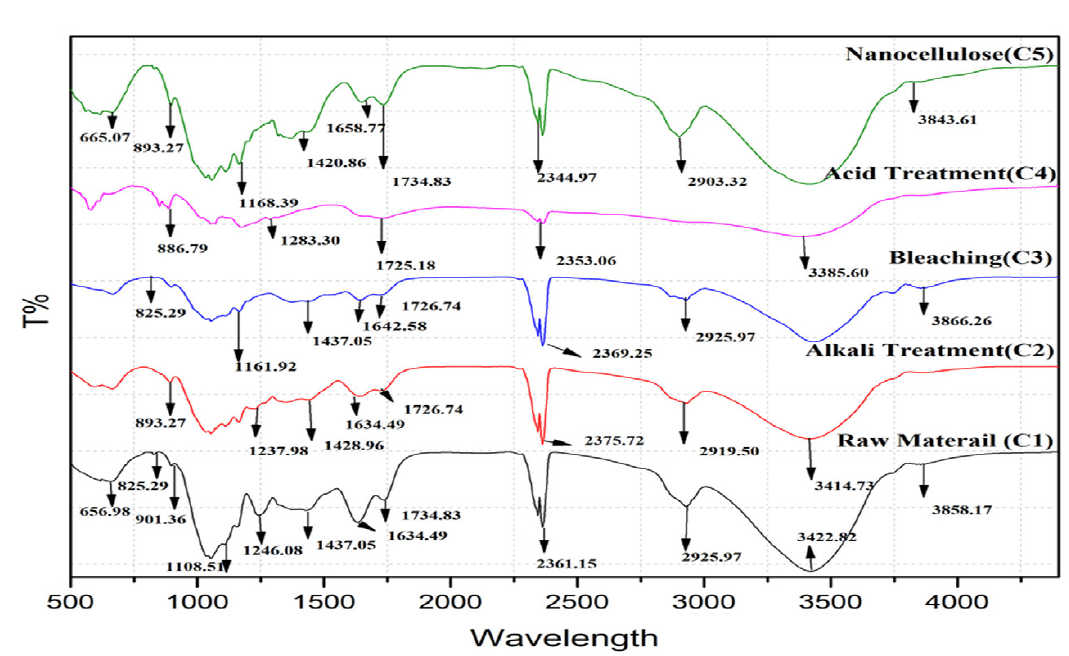
Fig. 4. FTIR analysis of processed